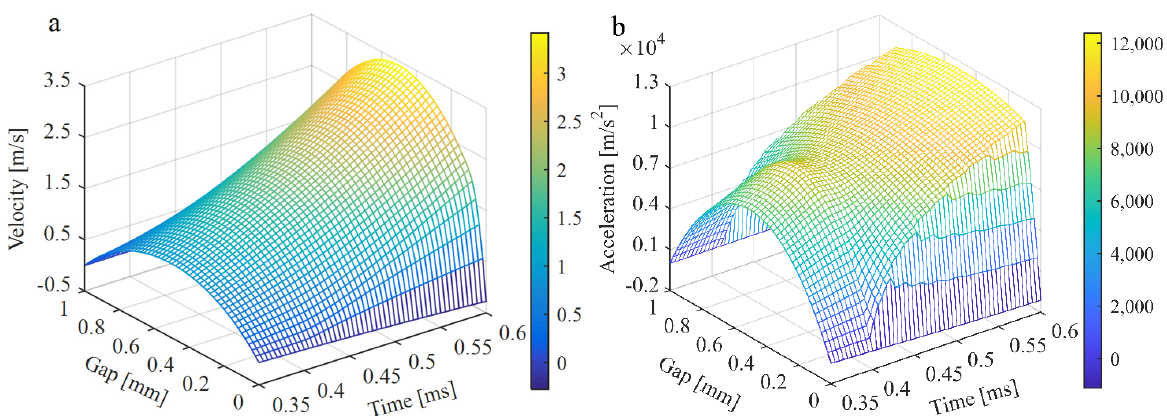
Figure 22. Space-time dynamic distribution of MR fluid velocity and acceleration during the transition flow stage in the activated region for the 2 A excitation current.